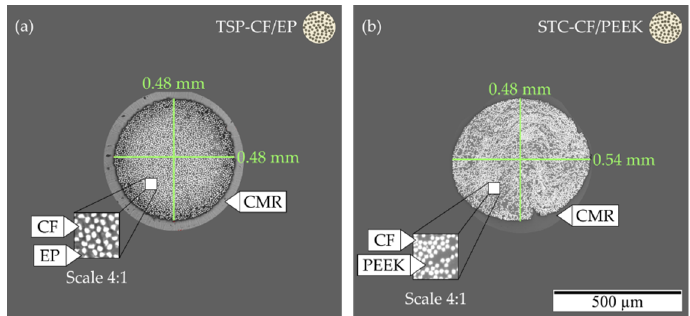
Figure 8. Photomicrographs of carbon fibre (CF) reinforced polymers manufactured by means of thermoset pultrusion (TSP) and thermoplastic pultrusion (TPP) embedded in cold mounting resins (CMR): ( a ) CF / epoxy resin (EP), D = 0.47 mm; ( b ) CF / polyether ether ketone (PEEK), D = 0.43 mm.